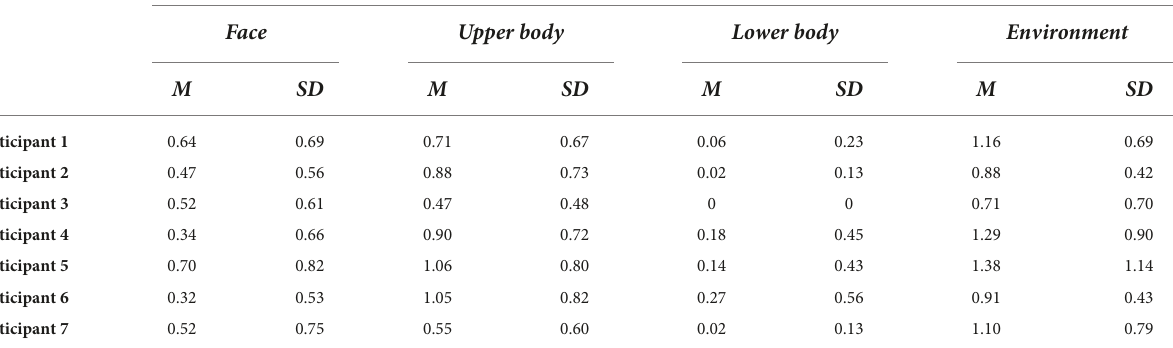
TABLE 3 Means and standard deviation of the number of fixations of the participants on the AOIs face, upper body, lower body, and environment included in the statistical